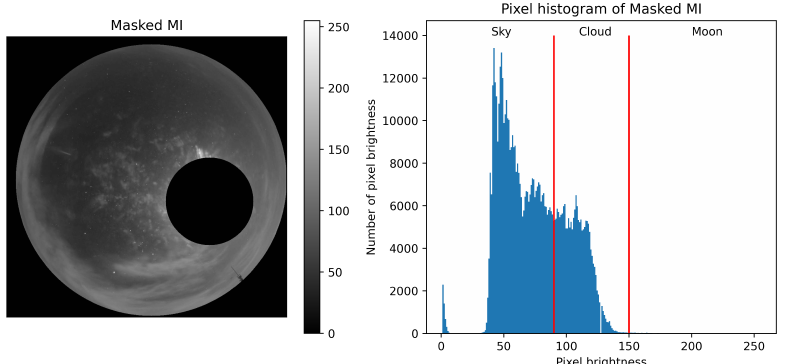
Figure 5. ( Left ) A masked moonlight image. ( Right ) Image histogram, the left vertical line indicates the threshold value, which is obtained by our method, and the right vertical line is the gray value